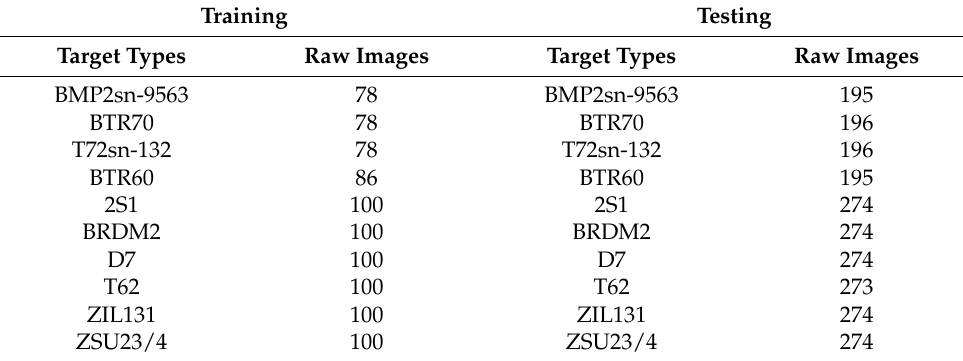
Table 1. Raw SAR image selection from the MSTAR